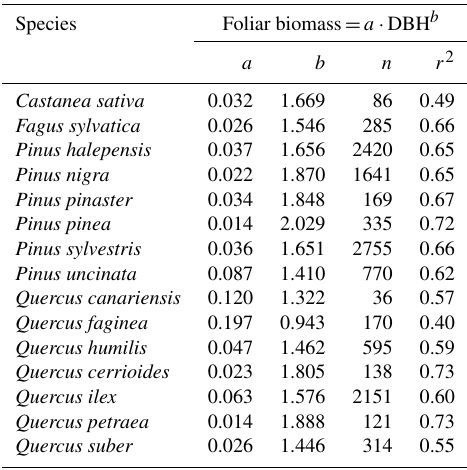
Table A1. Allometric relationships between foliar biomass and DBH for the different species included in this analysis. DBH is diameter at breast height (cm). Adapted from Sardans and Peñuelas